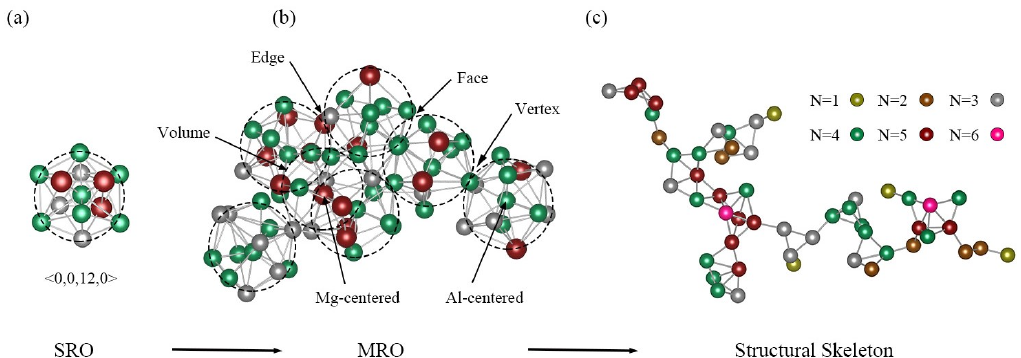
Figure 9. The hierarchical atomic structures for Al 35 Mg 35 Zn 30 : ( a ) The coordination mode in the local SRO is displayed by a typical Al-centered icosahedra <0,0,12,0>. ( b ) The packing mode in the MRO is characterized by a super-cluster formed among 7 neighboring FIs; each FI is highlighted with a dashed circle. The Al, Mg, and Zn atoms are colored green, red, and gray, respectively. ( c ) As for the extended scale, only the center atom of each FI is plotted as a point, and the connection mode of the structural skeleton is exhibited by a cross-linked patch containing 52 FIs. The six colors correspond to various bond numbers.